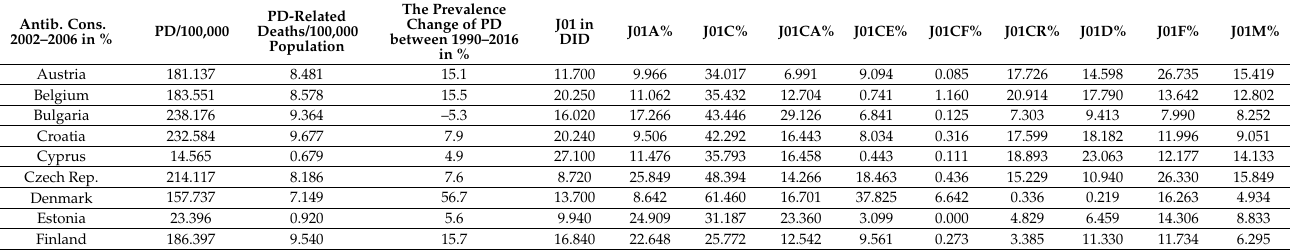
Table 2. Average antibiotic consumption for 2002–2006 expressed as a relative share in % of the total systemic antibiotic consumption in the community estimated in Defined Daily Dose/1000 Inhabitants/Day (DID) compared to the prevalence of PD estimated for 2016, the change of prevalence between 1990–2016 in percentage (%), and the PD-related deaths/100,000 population. Positive, significant correlation or significantly elevated risk was estimated, when the p -value showed ≤ 0.05 ( p = ≤ 0.05) (marked with yellow filling color) and the negative correlation or lowered risk was marked with green filling color. Positive/negative, non-significant correlations or elevated/lowered risks were considered when the p -value fell between 0.051 and 0.09 ( p = 0.051 ≤ 0.09) and marked with an orange filling